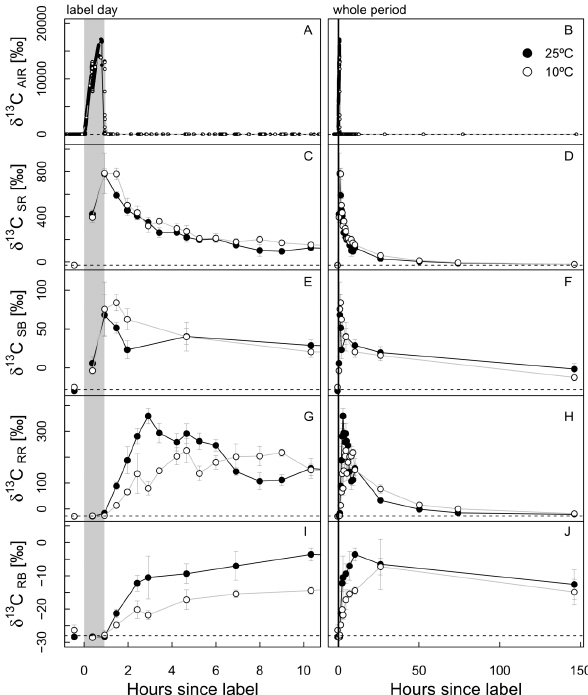
1 Figure 1: Time course of δ 13 C over the duration of the experiment, during label day ( left 2 Fig. 1. Time course of δ 13 C over the duration of the experiment, panels ) and the whole measurement period ( right panels ). Panels show δ 13 C of the cabinet air 3 during label day (left panels) and the whole measurement period (δ 13 C AIR ; A, B); shoot respired CO 2 (δ 13 C SR ; C, D); bulk shoot material (δ 13 C SB ; E, F); root 4 (right panels). Panels show δ 13 C of the cabinet air ( δ 13 C AIR ; A , B ); respired CO 2 (δ 13 C RR ; G, H) and bulk root material (δ 13 C RB ; I, J). Duration of label 5 shoot respired CO 2 ( δ 13 C SR ; C , D ); bulk shoot material ( δ 13 C SB ; application is indicated by the grey shaded area, and natural abundance by the horizontal 6 E , F ); root respired CO 2 ( δ 13 C RR ; G , H ) and bulk root material dashed line. Closed and open symbols indicate the warm (25 ºC) and cold (10 ºC) treatments, 7 ( δ 13 C RB ; I , J ). Duration of label application is indicated by the respectively. Data are means ± standard error ( n = 3) 8 grey shaded area, and natural abundance by the horizontal dashed line. Closed and open symbols indicate the warm (25 ◦ C) and cold (10 ◦ C) treatments, respectively. Data are means ± standard error ( n =